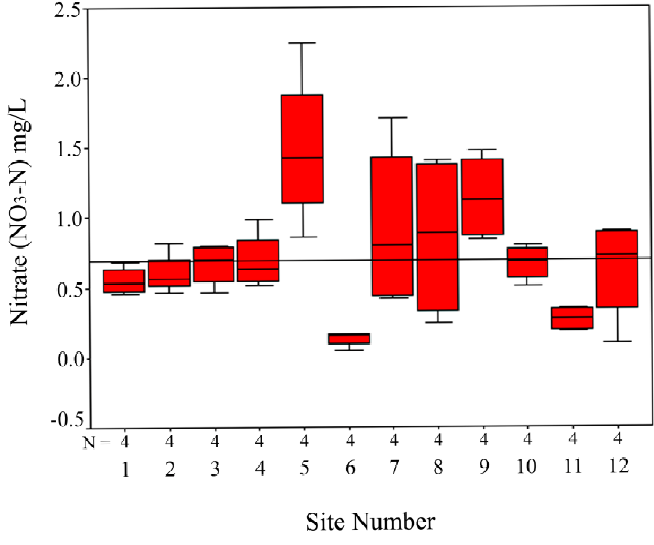
Figure 5. Box plot of nitrate (NO ) concentrations in mg/L by site (4 samples/site) in the 3 Little Choctawhatchee River watershed from October 2007 to June 2008. Reference line indicates U.S. EPA suggested criteria for TN as N (0.69 mg/L as